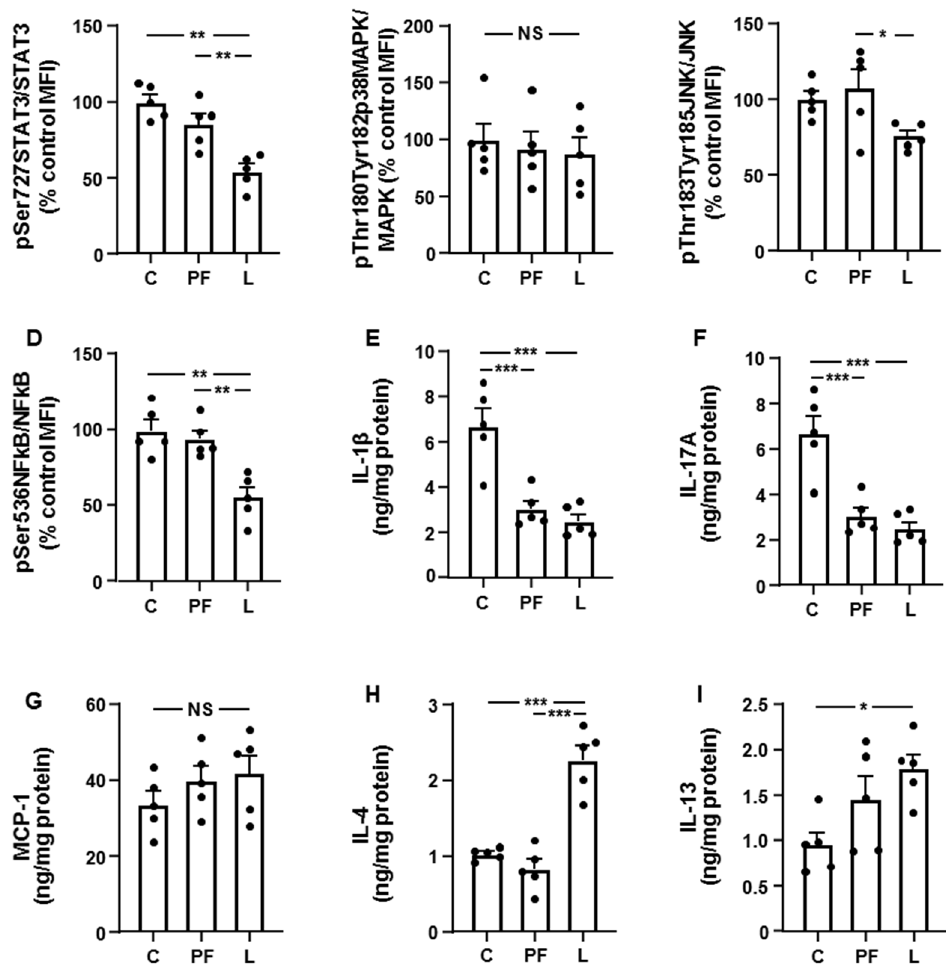
Figure 2. Effect of leptin infusion on inflammatory markers in the liver. Relative protein levels of ( A ) signal transducer and activator of transcription 3 (STAT3) phosphorylated (p) at Ser727 (pSer727STAT3), ( B ) phosphorylated p38 mitogen-activated protein kinase (p38MAPK) at Thr180 and Tyr182 (pThr180Tyr182p38MAPK), ( C ) c-Jun N-terminal kinase (JNK) phosphorylated at Thr183 and Tyr185 (pThr183Tyr185JNK), and ( D ) nuclear factor kappa B (NFkB) phosphorylated at Ser536 (pSer536NFkB), and ( E ) interleukin (IL)1 β , ( F ) IL-17A, ( G ) monocyte chemoattractant protein-1 (MCP-1), ( H ) IL-4 and ( I ) IL-13 content in the liver of control rats ( C ), pair-fed rats (PF) and rats receiving a chronic intracerebroventricular leptin infusion (L). Data are presented as means ± SEM. MFI, median fluorescence intensity; NS, non-significant. * p < 0.05, ** p < 0.01, *** p < 0.001.